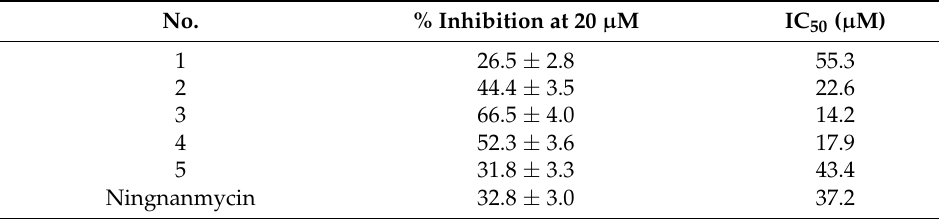
Table 4. Anti-TMV activity of compounds 1 – 5 on Nicotiana glutinosa leaf a .